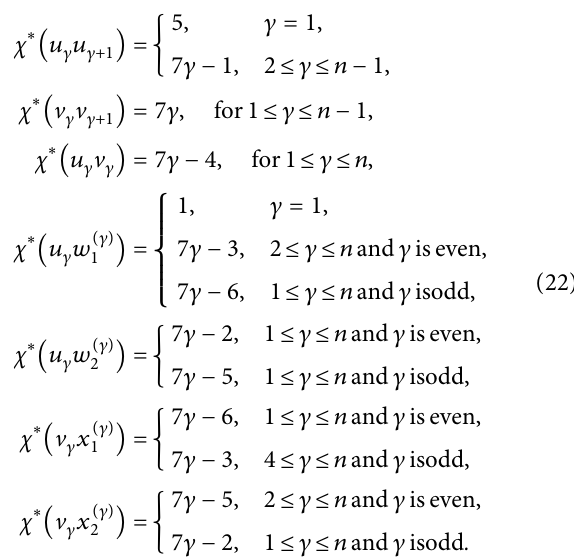
× P × P , P , and P 2 4 3 8